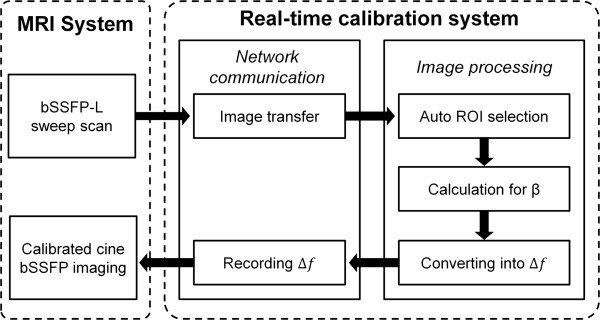
The framework of the proposed real-time feedback calibration system. The reconstructed bSSFP-L images are transferred to an external PC synchronously through an Ethernet network and the PC processes the sweep scan datasets, obtains the optimal β, converts β into frequency offset and records it in an F-file. Finally, the subsequent bSSFP imaging program reads F-file and adjusts the offset frequency of the imaging sequence to achieve real-time calibration without user interactions.